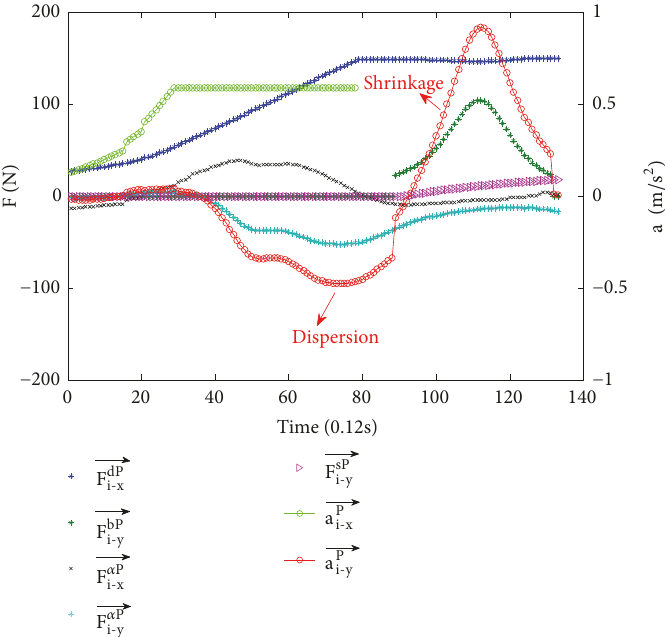
Figure 20: Force and acceleration in the